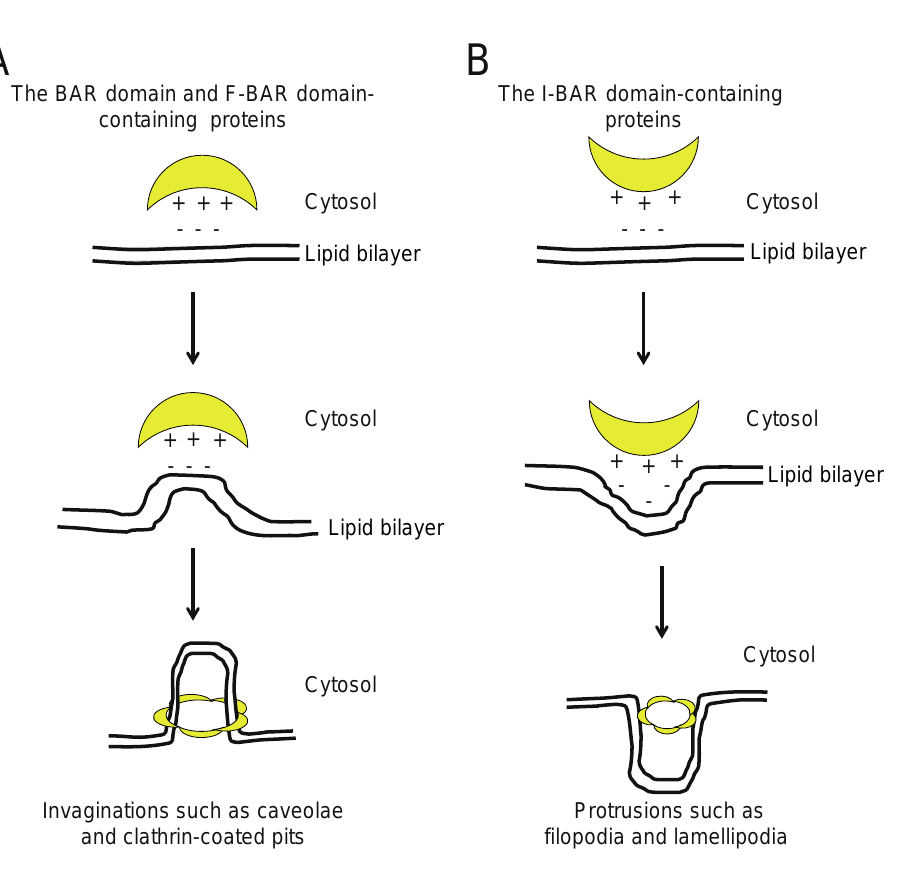
Figure 2. Schematic models for membrane deformation, based on the geometries of basic-charged amino acid residues that correspond to the structures of the membrane-binding surface of the F-BAR domain-containing proteins. ( A ) BAR or F-BAR proteins bind to the membrane to generate invaginations, such as caveolae and clathrin-coated pits; ( B ) I-BAR proteins deform the membrane to generate protrusions, such as filopodia and